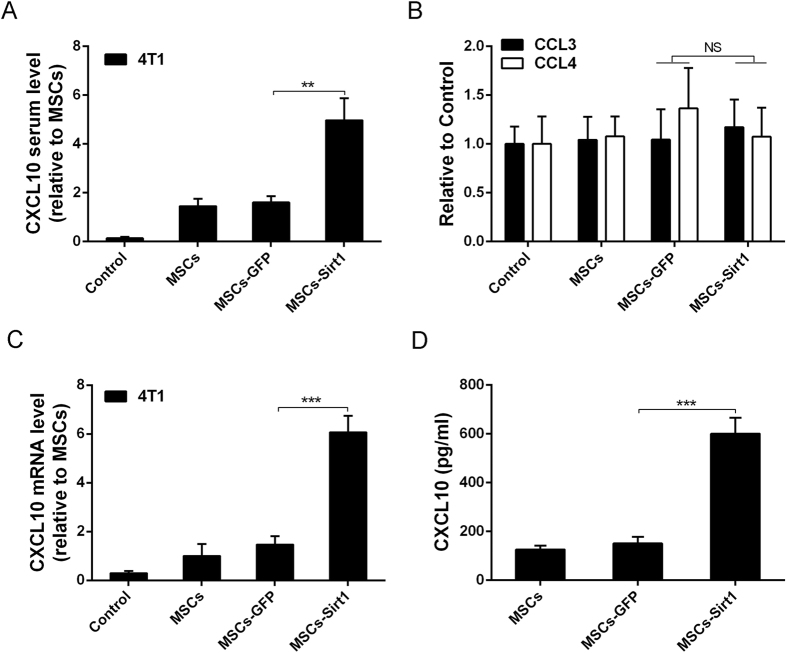
The evaluation of chemotactic factors production.ELISA kit was utilized to determine the serum chemotactic factors level of tumor-bearing mice, including CXCL10 (A), CCL3 and CCL4 (B). Results were reported as ratio to MSCs group. Serum samples were taken at the 18th day since cells subcutaneous injection. Each group consists of 5 mice. (C) Real-time PCR was employed to examine the CXCL10 expression level of tumors and the data were reported as ratio to MSCs group. Each group consists of 5 mice. (D) ELISA assay was also used to examine the CXCL10 expression in the conditioned medium of MSCs, MSCs-GFP and MSCs-Sirt1. The data presented are from three replicates as mean ± SD. **, P < 0.01; ***, P < 0.001; NS, P > 0.5.